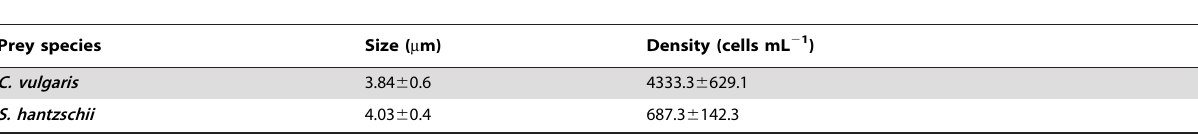
Table 1. Size and density of two food algal species used in the